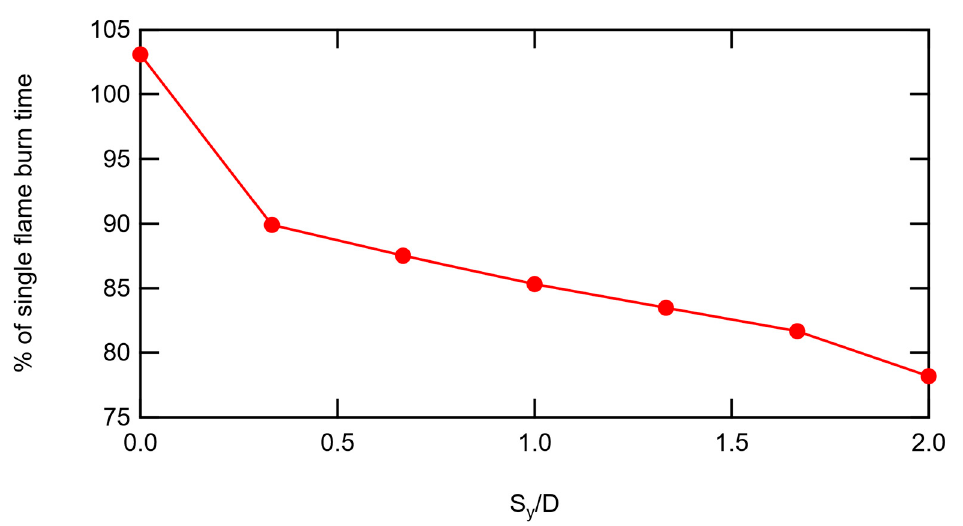
Figure 18. Normalized flame duration times for the top flame in the two-pad experiments with no horizontal separation ( S x /D = 0).